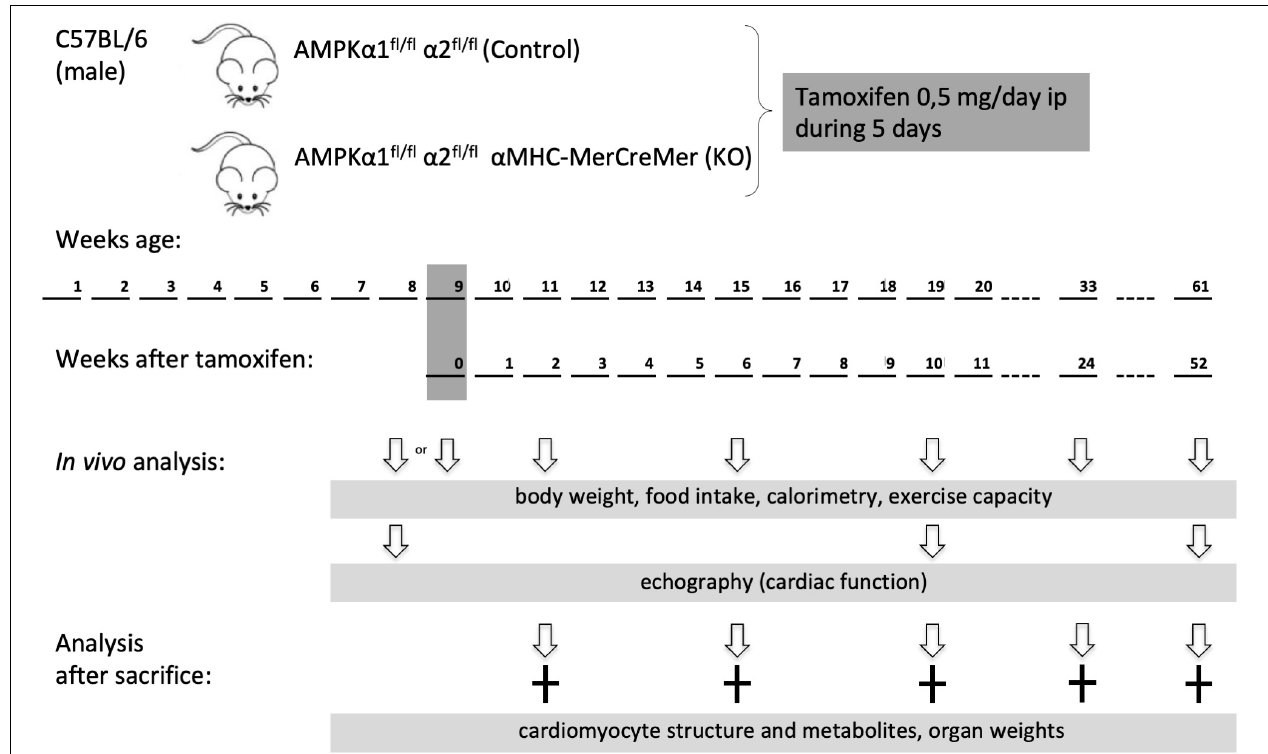
FIGURE 1 | Study design. Eight week old male mice were administered tamoxifen (0.5 mg/day) for five consecutive days and then analyzed at different time points as indicated. Phenotype in vivo was followed over 1 year in a group 30 mice (13 control and 17 KO). For other experimental series, additional groups of mice were used, at different time points after KO